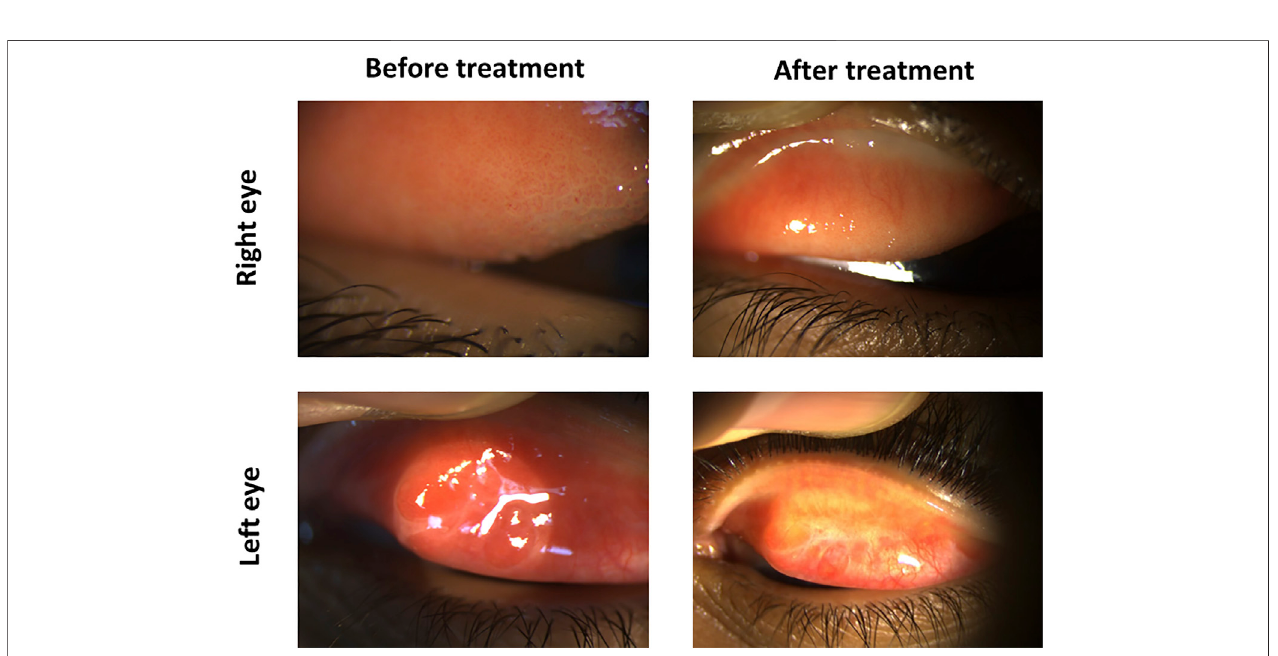
Frontiers in Pharmacology |